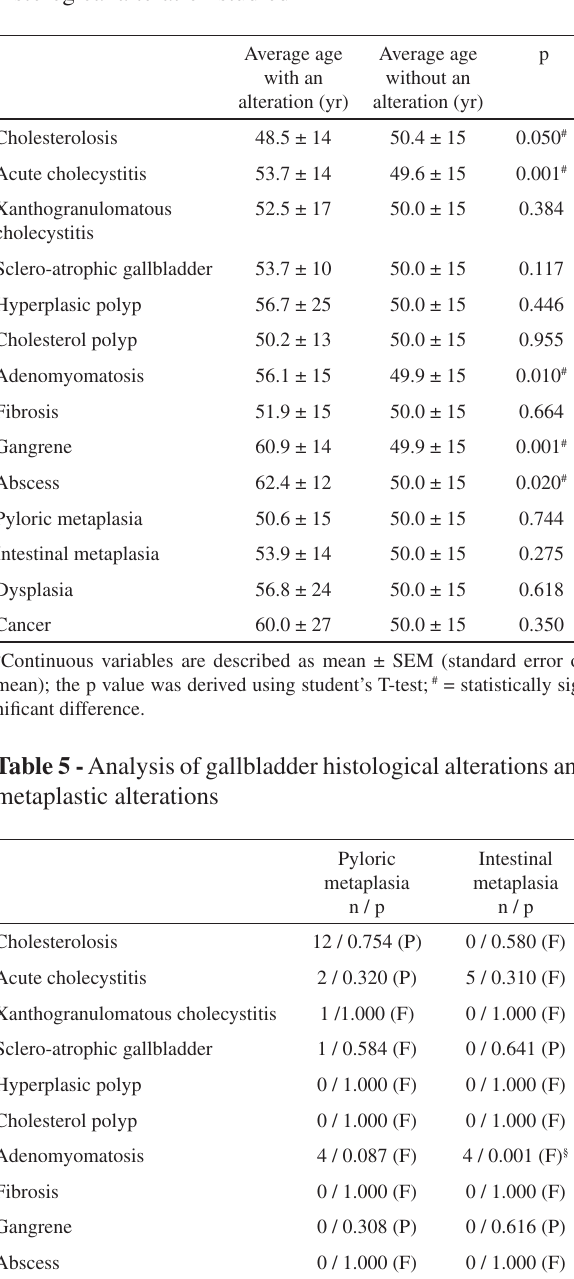
Table 4 - Average age of occurrence of each gallbladder histological alteration studied +